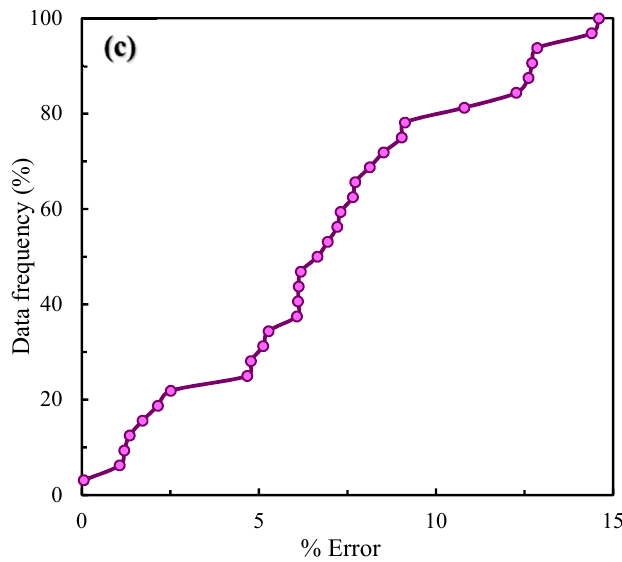
Figure 6. Experimental vs. computed maximum non-dimensional scour depths. ( a ) 70% training datasets. ( b ) 30% validation datasets. ( c ) Comparison between percentage data frequency and percentage error.